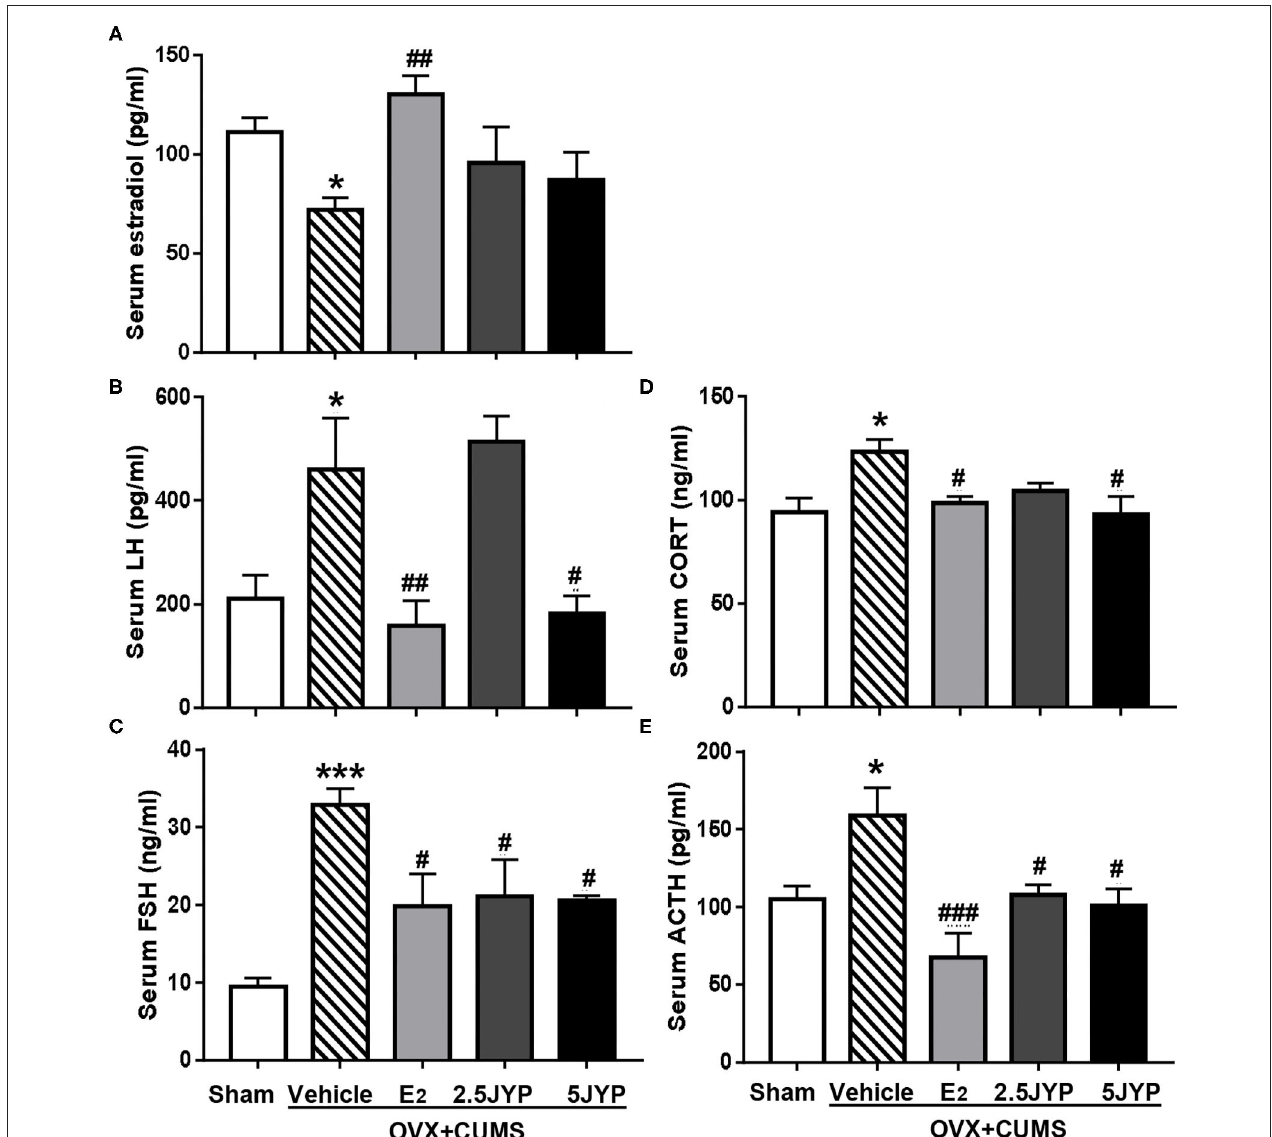
FIGURE 6 | Effects of 2.5 g/kg JYP (2.5 JYP), 5.0 g/kg JYP (5 JYP), and 0.3 mg/kg estradiol (E2) on serum hypothalamic–pituitary–adrenal (HPA) and hypothalamic-pituitary-ovarian (HPO)-axis hormones with E 2 (A) , luteinizing hormone (LH) (B) , follicle stimulating hormone (FSH) (C) , corticosterone (CORT) (D) , and adrenocorticotropic hormone (ACTH) (E) . Data are expressed as mean ± SEM ( n = 4) and examined with one-way analysis of variance (ANOVA), followed by post hoc between-group comparisons: * P < 0.05, *** P < 0.001 vs. sham group; # P < 0.05, ## P < 0.01, ### P < 0.001 vs. vehicle